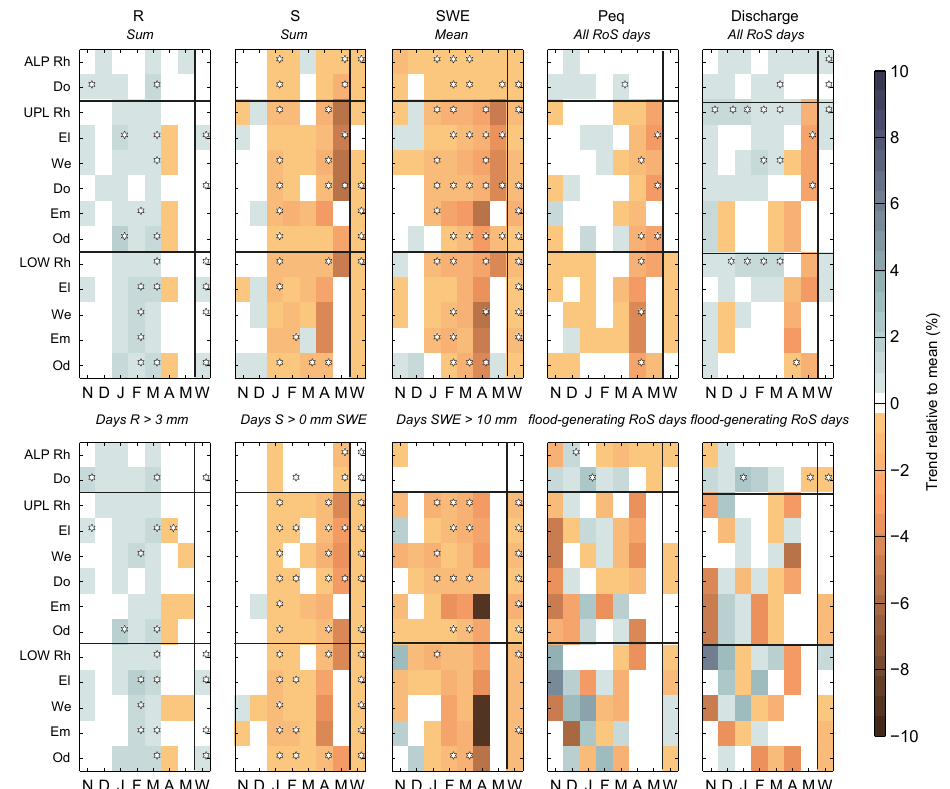
Figure 6. Comparison of the long-term trends (1950–2011) of the total equivalent precipitation depth, the snow water equivalent, the snowfall, and the rainfall for the individual months November–May (N–M) and the winter season (W) for the alpine (ALP), upland (UPL) and lowland (LOW) sub-basins of the Rhine (Rh), Danube (Do), Elbe (El), Weser (We), Oder (Od), and Ems (Em). Trends are given as the yearly change relative to the mean of the period 1950–2011. Statistically significant trends at p < 5% are shown with a red star.